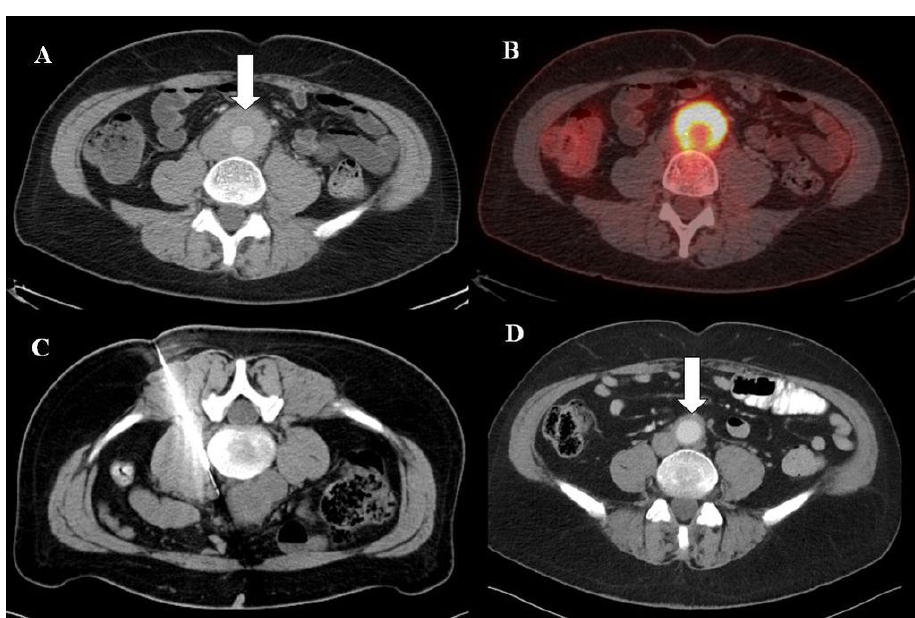
Fig. 5. The true negative result. Vascularized mass around the abdominal aorta on contrast me- dium enhanced CT (A, arrow) and on FDG enhanced PET/CT (B). The placement of the biopsy needle (C, patient in prone position) with long skin to lesion distance. The histological result was immunoglubulin G4-related disease. The systemic corticosteroid anti-inflammatory treatment was indicated and follow-up CT examination after 6 months verified almost complete regression of the periaortic